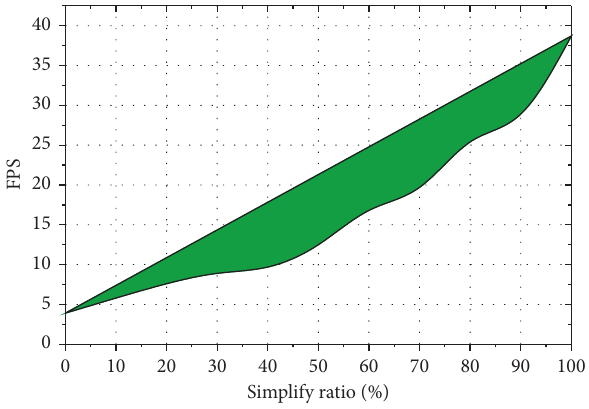
Figure 8: Model frame rate